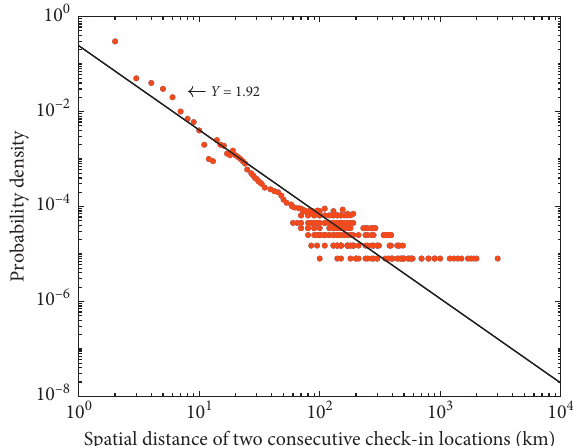
Figure 4: The spatial distance distribution of two consecutive check-in